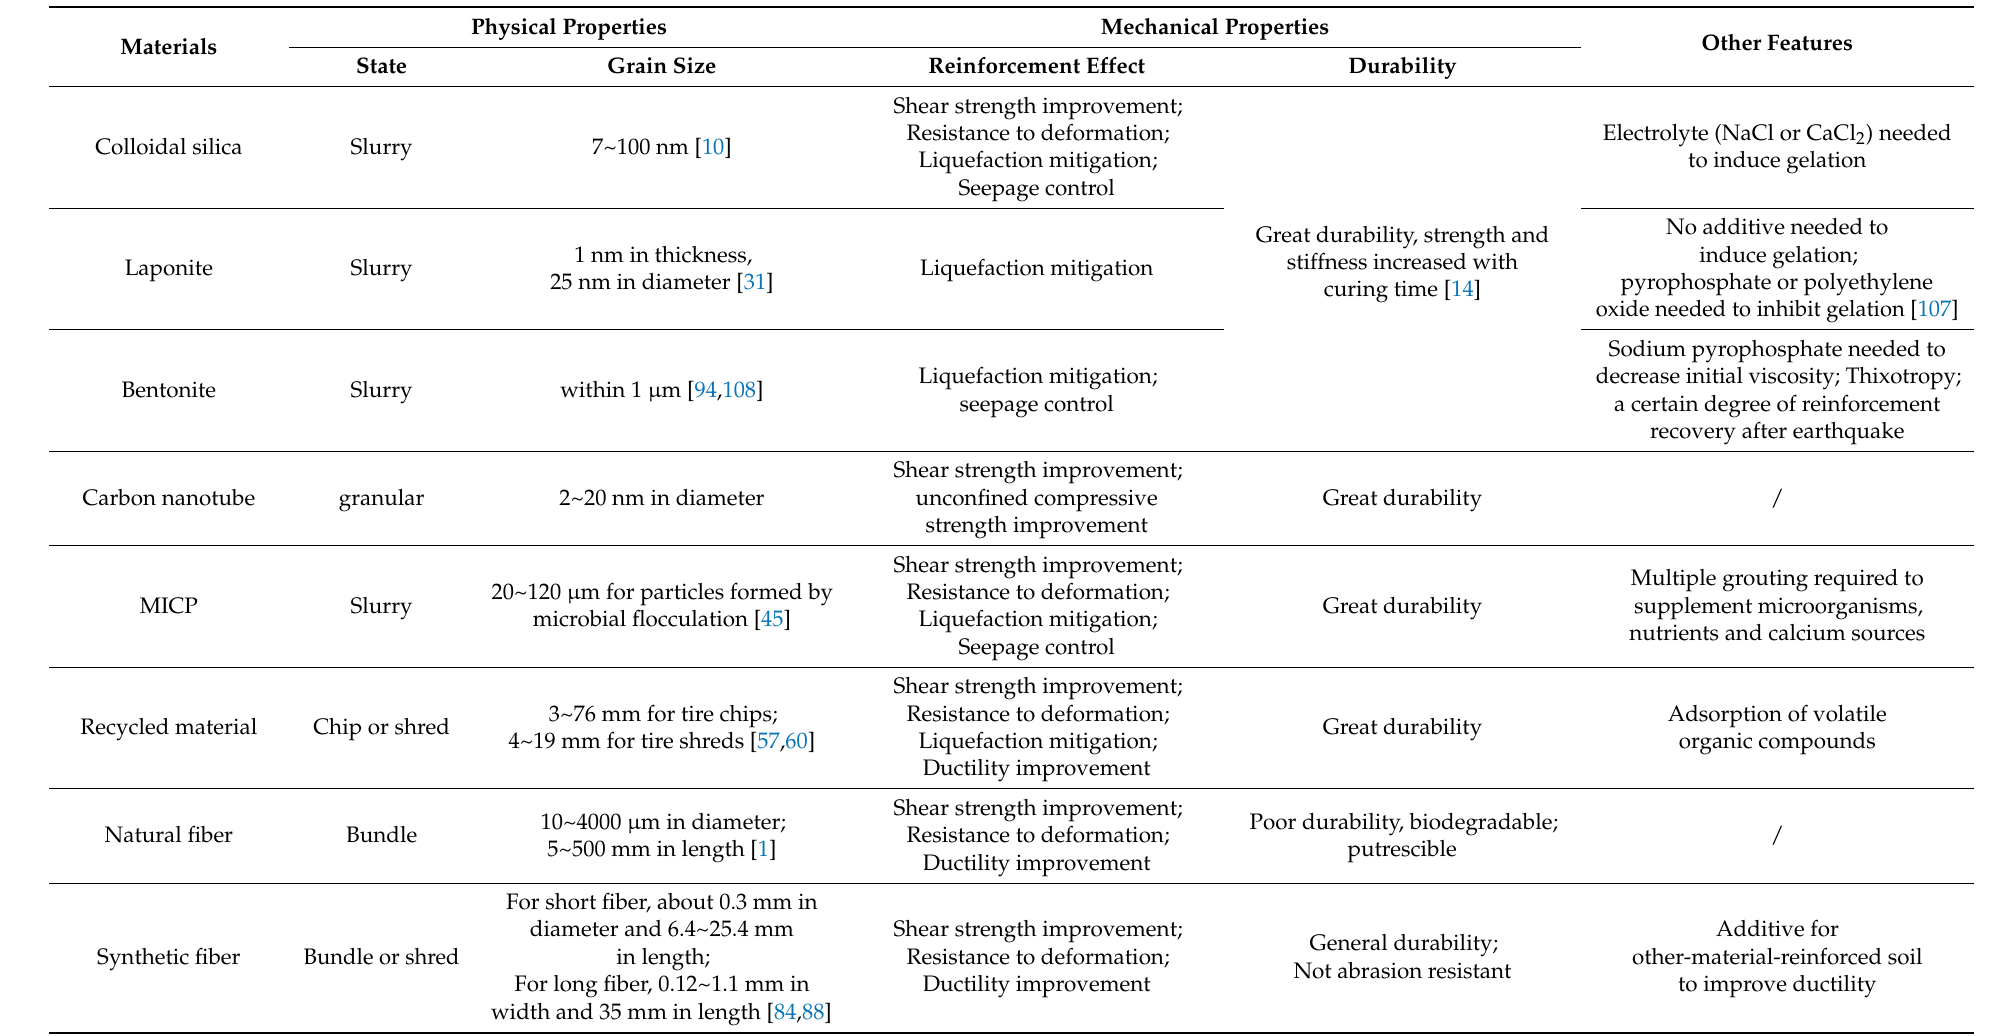
Table 1. Comparison of properties for the investigated unconventional